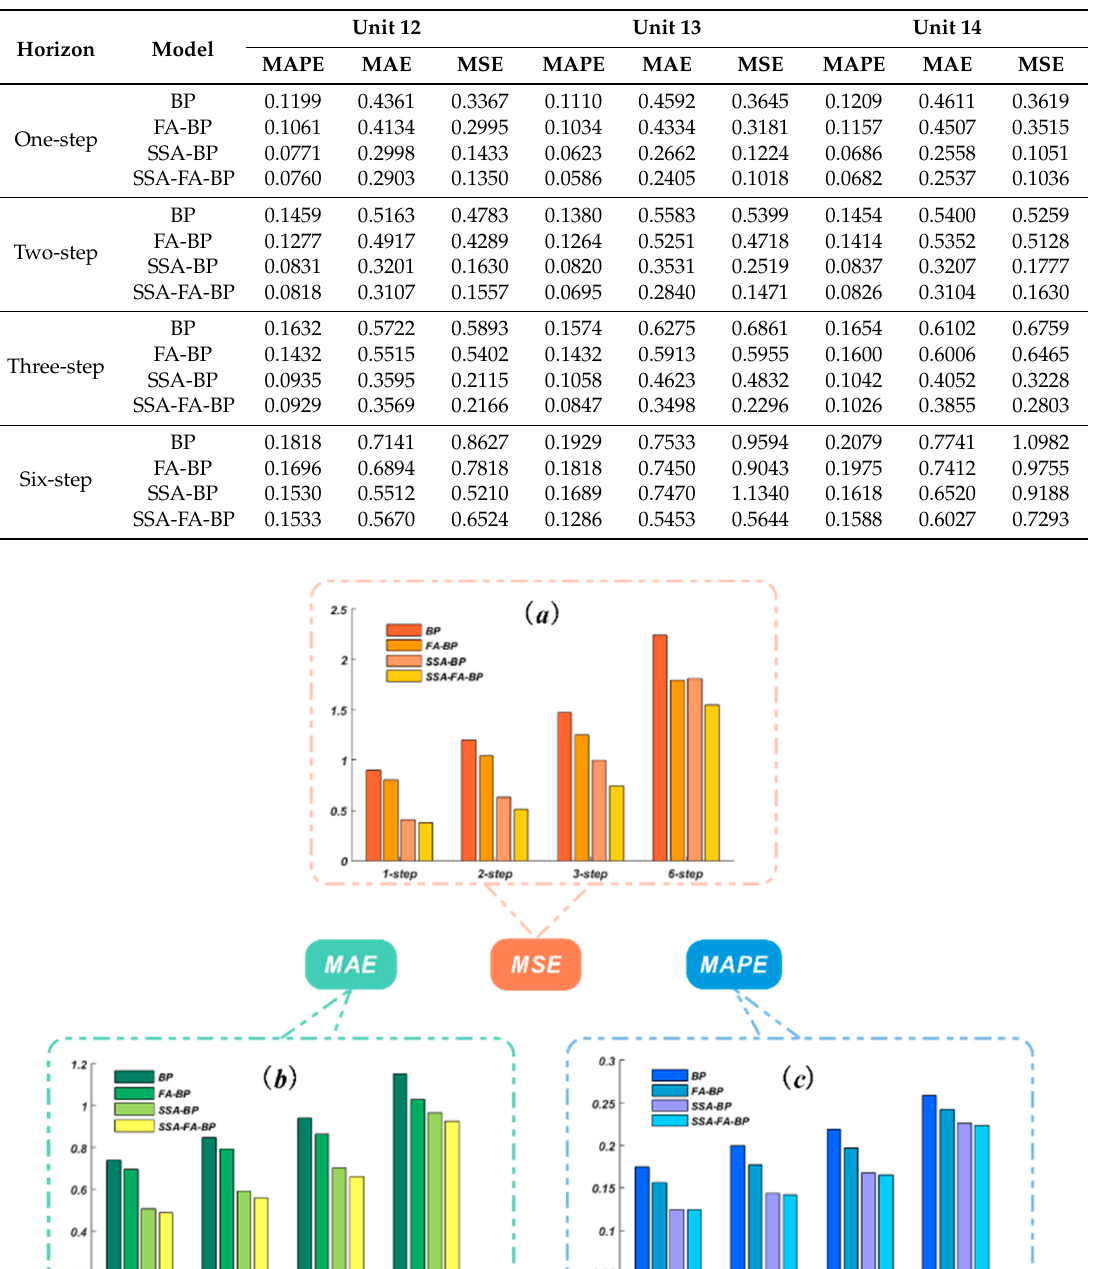
Table 5. The quarterly average forecast results of the combined model and the results of the other models involving the data of three units (30 min).